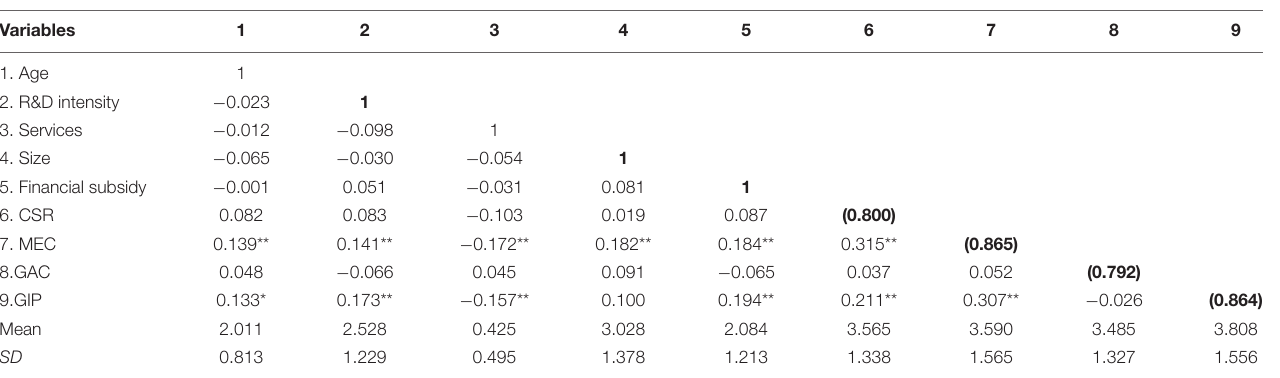
TABLE 3 | Mean, SD, and